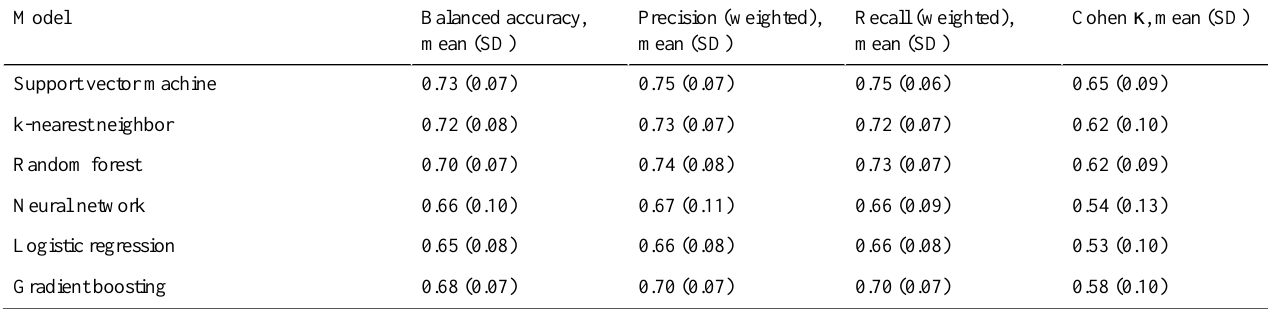
Table 3. Performance of candidate models with the training data set.